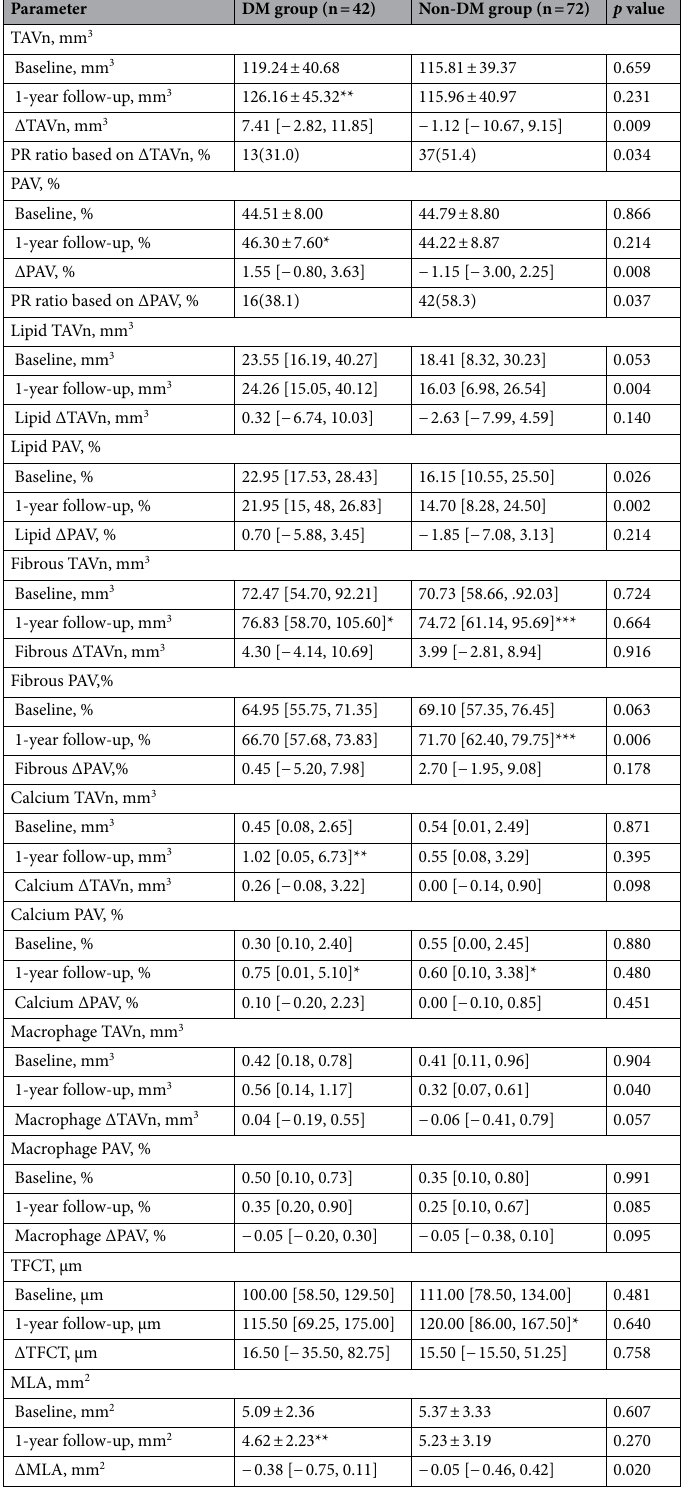
Table 3. nCSA changes measured by OFR for patient with or without DM in phase II analysis. Values are expressed as the median (interquartile range) for continuous variables with abnormal distribution and described as the mean ± standard deviation with normal distribution, or frequency (percentage) for categorical variables in the table. DM diabetes mellitus, MLA minimal luminal area, nCSA non-culprit subclinical atherosclerosis, OFR optical flow ratio, PAV percent atheroma volume, TAVn normalized total atheroma volume, TFCT thinnest fibrous cap thickness. *** p < 0.001; ** p < 0.01; * p < 0.05 these values were compared between baseline and 1-year